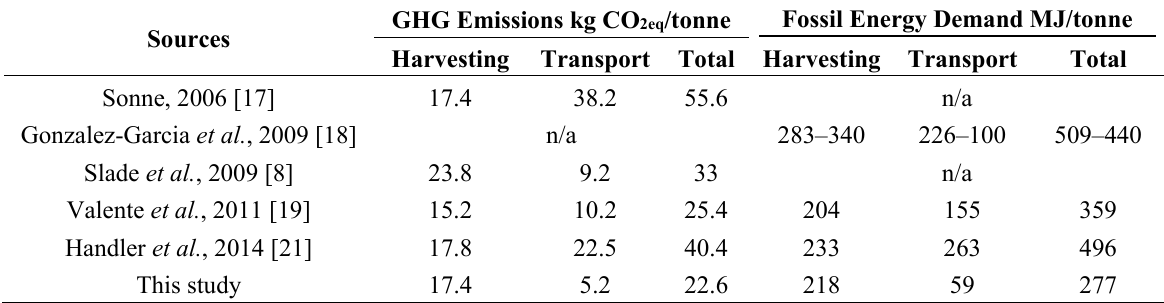
Table 8. Comparison of forest biomass supply life cycle environmental